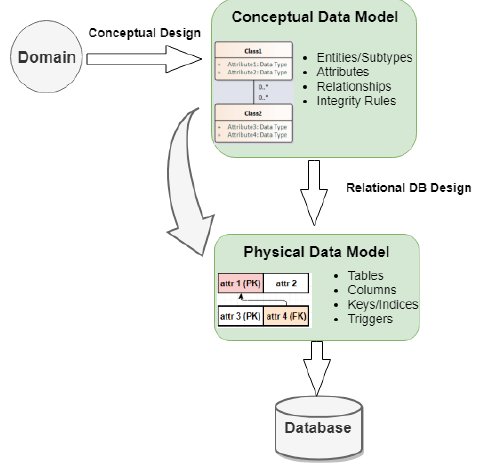
Figure 3. The process of data modeling